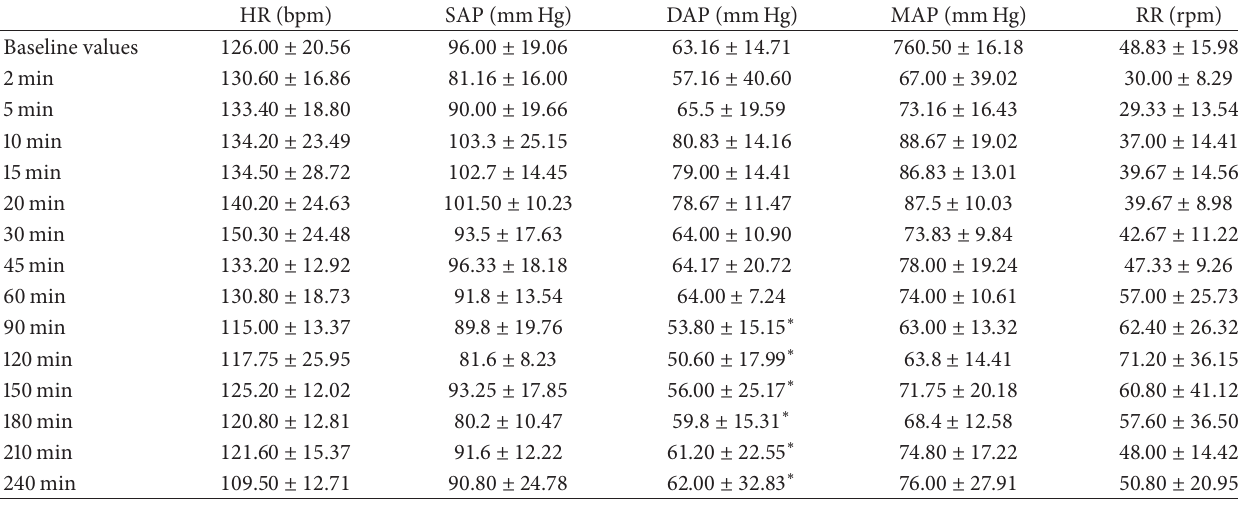
Table 1: Changes in maternal cardiovascular variables following administration of a single intravenous bolus of 2 mg/kg of alfaxalone in a 2-hydroxypropyl- 𝛽 -cyclodextrin formulation (mean ±